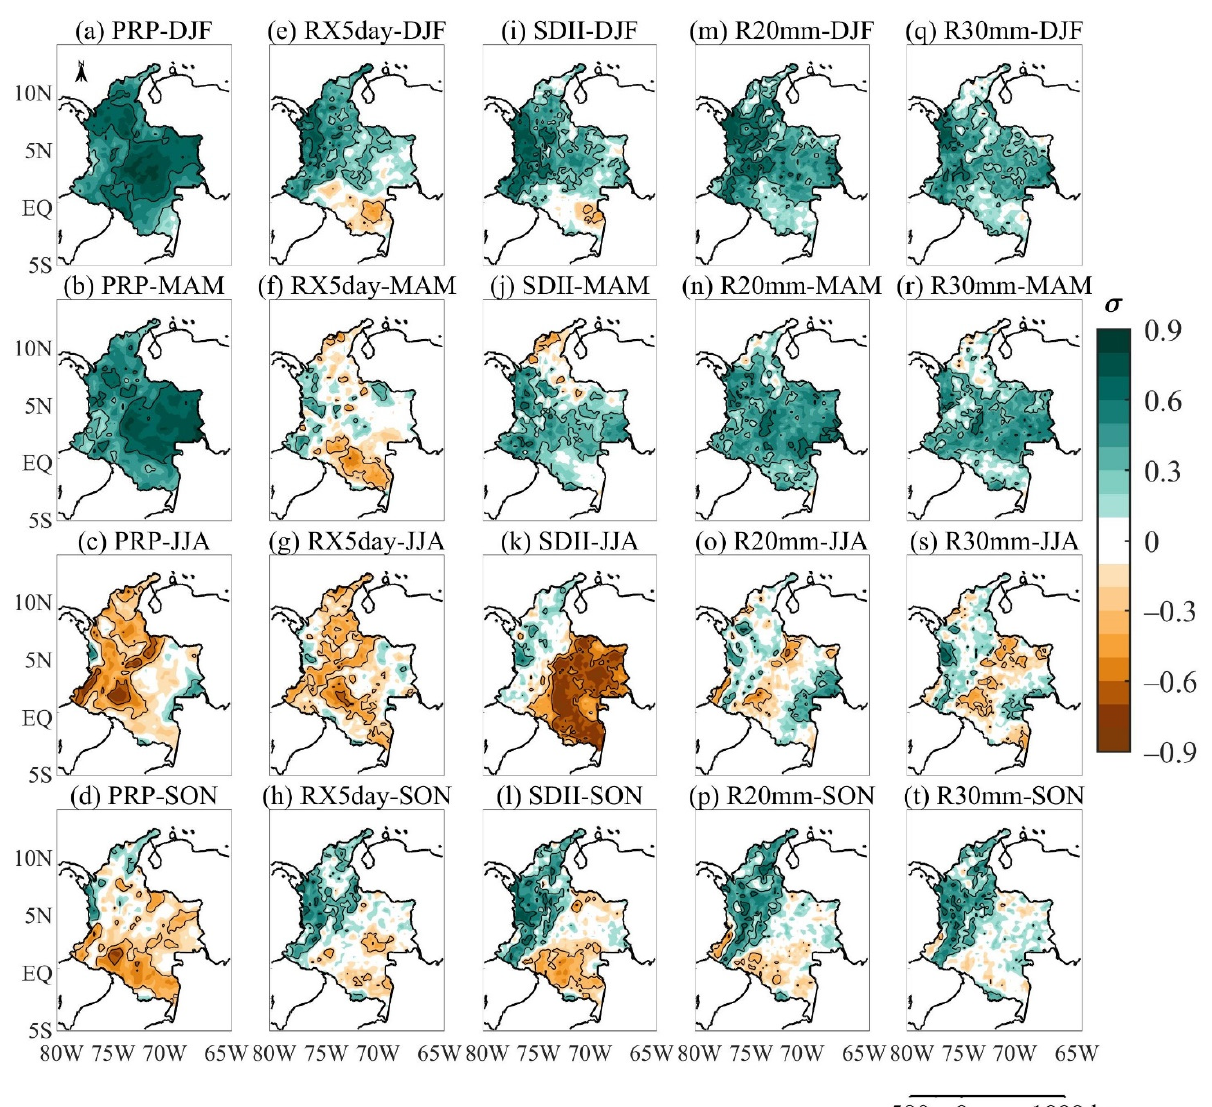
Figure 3. ( a )–( d ) Spatial pattern of total seasonal rainfall (PRP), ( e )–( h ) Max 5-day precipitation amount (RX5day), ( i )–( l ) Simple daily intensity index (SDII), ( m )–( p ) Number of days with precipitations above R20mm (R20mm), and ( q )–( t ) Number of days with precipitations above R30mm (R30mm) for the first TEOF mode during December–February (DJF) ( first row ), March–May (MAM) ( second row ), June–August (JJA) ( third row ), and September–November (SON) ( last row ).